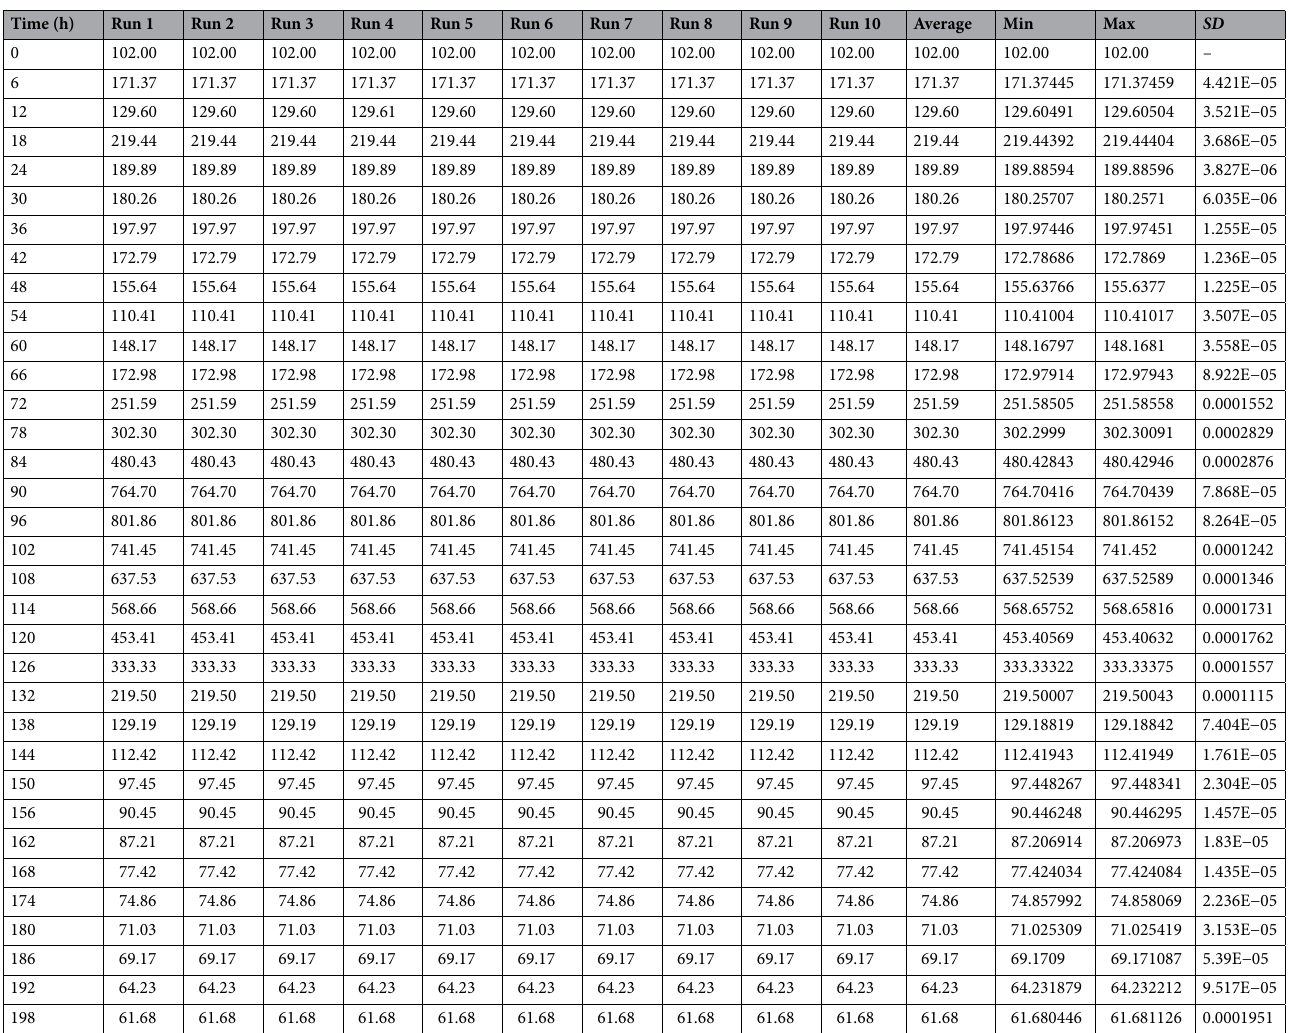
Table 2. Outflows (m 3 /s) calculated in 10 runs of “TLBO-Muskingum” for the Wye River benchmark